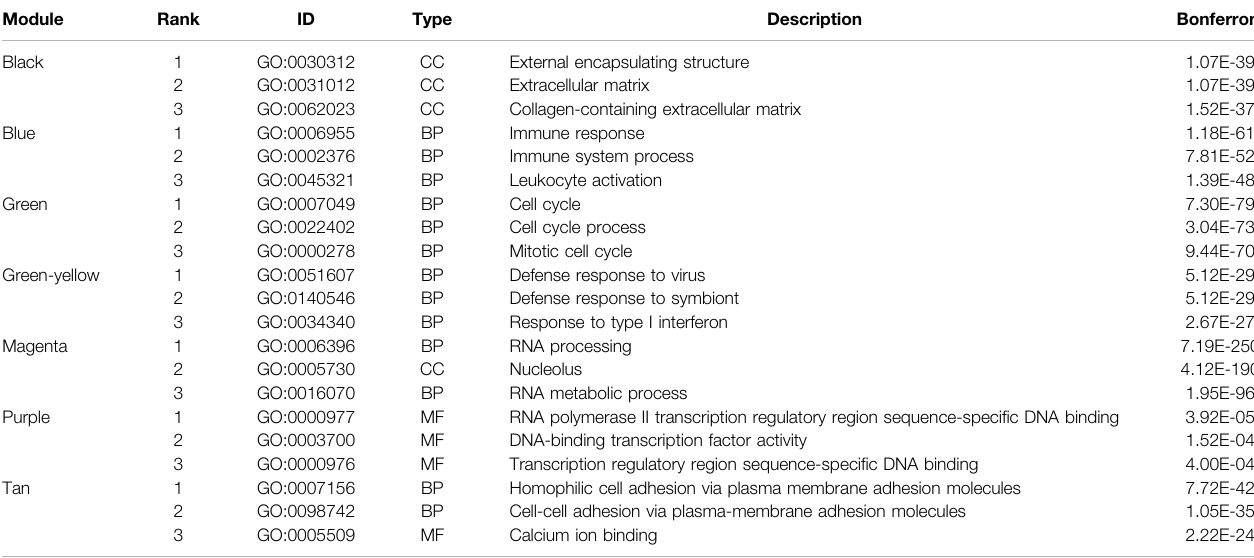
TABLE 1 | GO enrichment analysis of modules in WGCNA